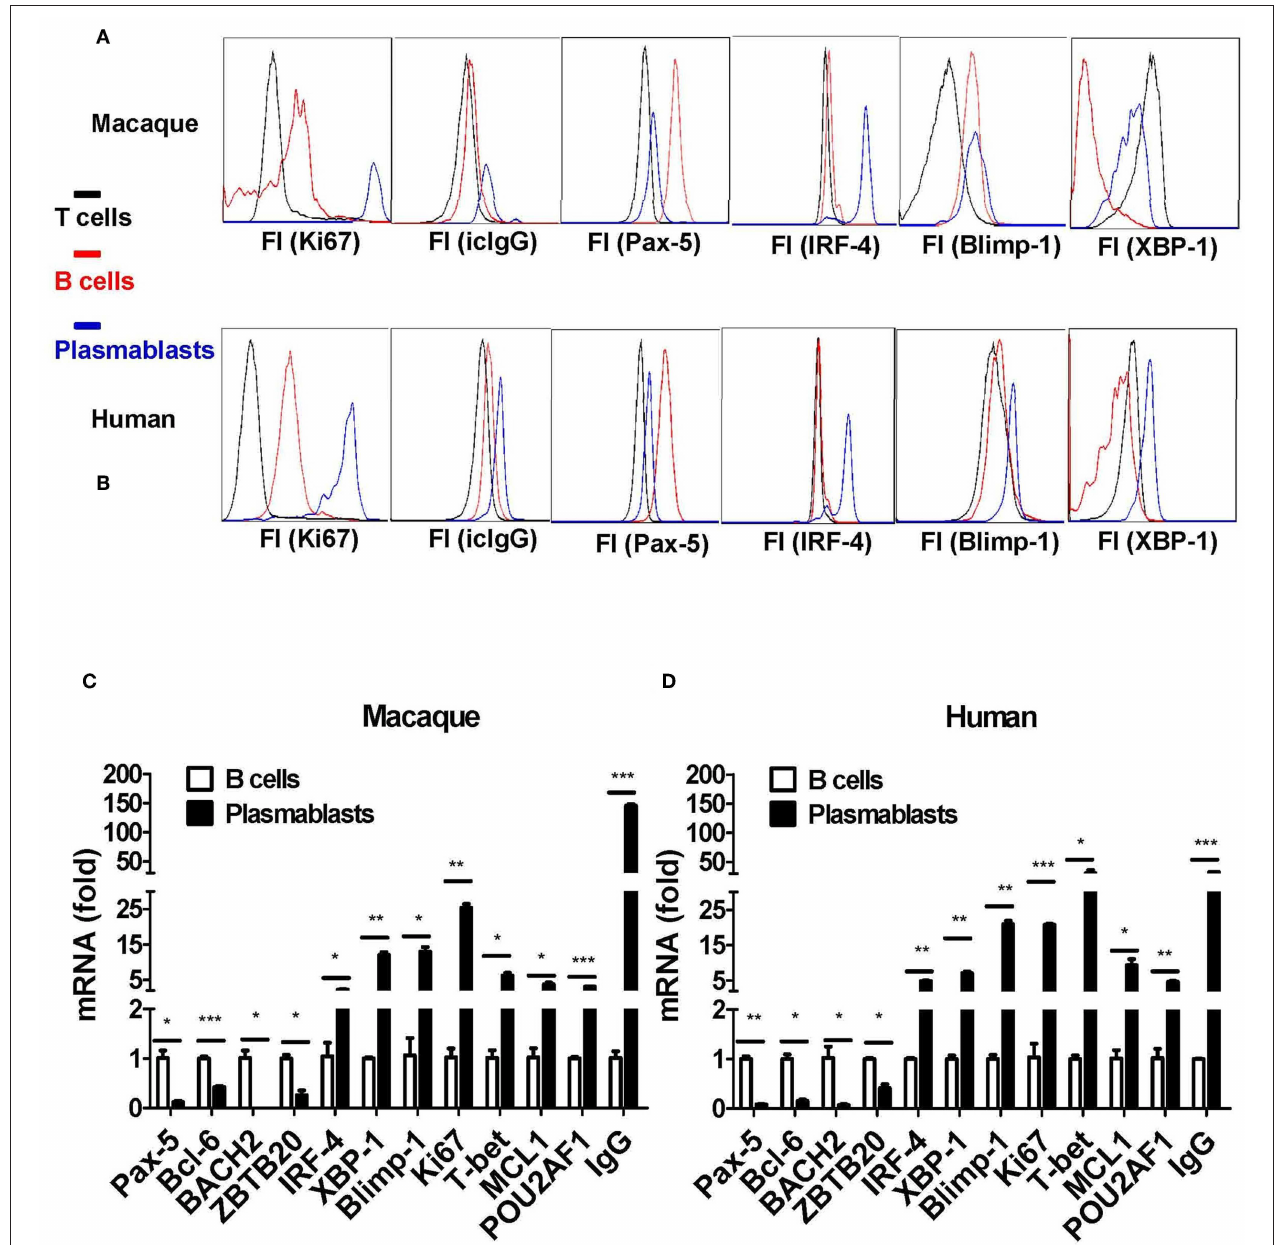
FIGURE 5 | Transcriptional characterization of antibody-secreting plasmablasts from Chinese rhesus macaques. (A) Intracellular protein expression of Ki67, IgG, Pax-5, IRF-4, Blimp-1, and XBP-1 by plasmablasts compared with T (CD3 + ) or B (CD20 + ) cells from Chinese rhesus macaques ( n = 4). (B) Intracellular protein expression of Ki67, IgG, Pax-5, IRF-4, Blimp-1, and XBP-1 by plasmablasts compared with T (CD3 + ) or B (CD20 + ) cells from human volunteers ( n = 3). (C) Macaque ( n = 4) plasmablasts and B cells (CD20 + ) were sorted at day 7 after booster vaccination. The mRNA levels of Pax-5, Bcl-6, BACH2, ZBTB20, IRF-4, XBP-1, Blimp-1, Ki67, T-bet, MCL1, POU2AF1/OBF1, and IgG were detected by qRT-PCR. (D) Human ( n = 3) plasmablasts and B cells (CD20 + ) were sorted at day 7 after booster vaccination. The mRNA levels of Pax-5, Bcl-6, BACH2, ZBTB20, IRF-4, XBP-1, Blimp-1, Ki67, T-bet, MCL1, POU2AF1/OBF1, and IgG were detected by qRT-PCR. The Chinese rhesus macaque plasmablast gating strategy was as follows: CD3 − CD14 − CD56 − CD19 − CD27 − CD20 − / low CD80 + HLA-DR + CD95 + . The human plasmablast gating strategy was as follows: CD3 − CD19 + CD20 − / low CD27 hi CD38 hi . The experiment has repeated a minimum of three times. Each bar represents Mean ± SEM. FI, fluorescence intensity; icIgG, intracellular IgG. * P < 0.05; ** P < 0.01; *** P <